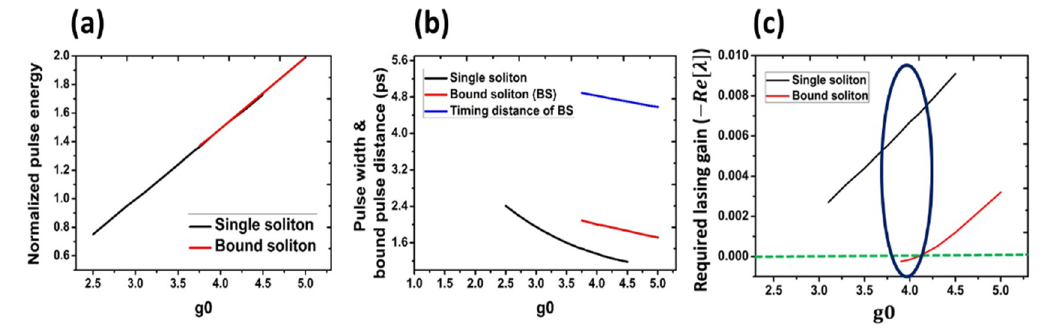
= 2.5; ( b ) bound-soliton case at 𝑔𝑔 0